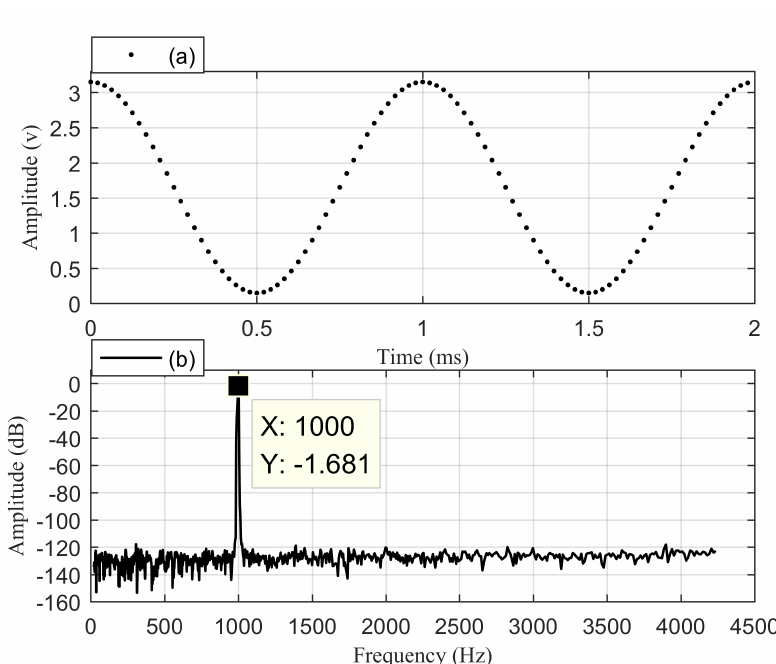
Figure 7. Simulated output signal waveform ( a ), output signal spectrum ( b ) of the digital decima- tion